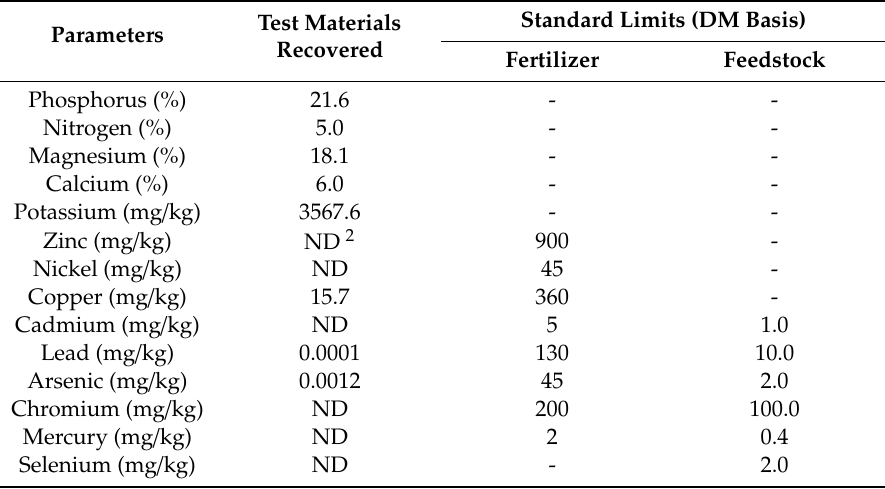
Table 6. Characteristics of recovered material from swine wastewater and the Korean standard limits of raw materials for fertilizer and